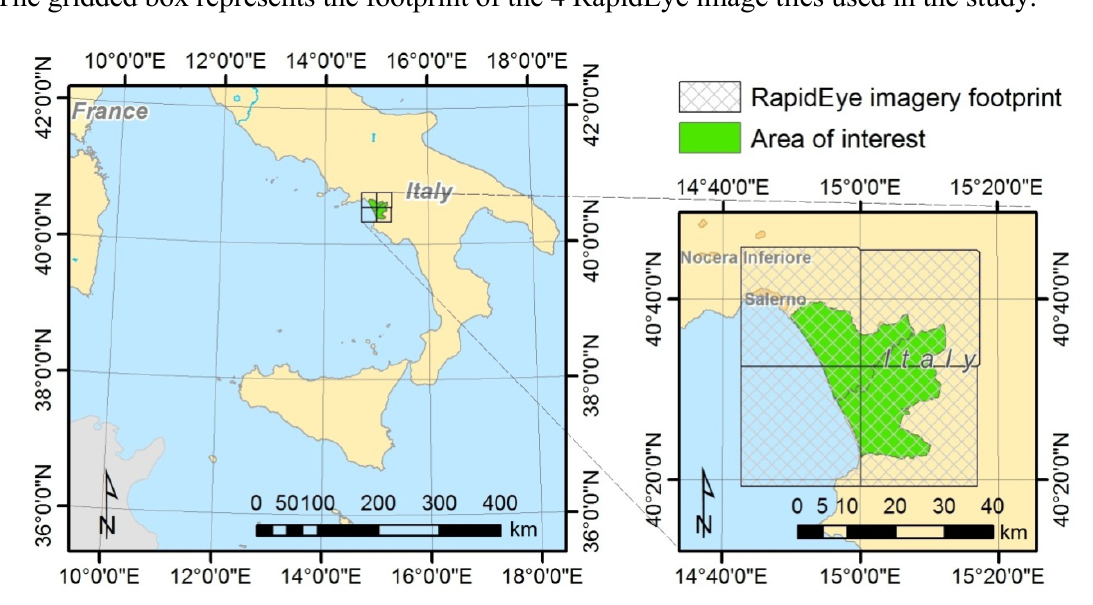
Figure 3. The study was carried out in Campania region in Southern Italy ( left ). The test site was located in the ‘Piana del Sele’ ( right ), one of the largest agricultural areas in the region. The gridded box represents the footprint of the 4 RapidEye image tiles used in the